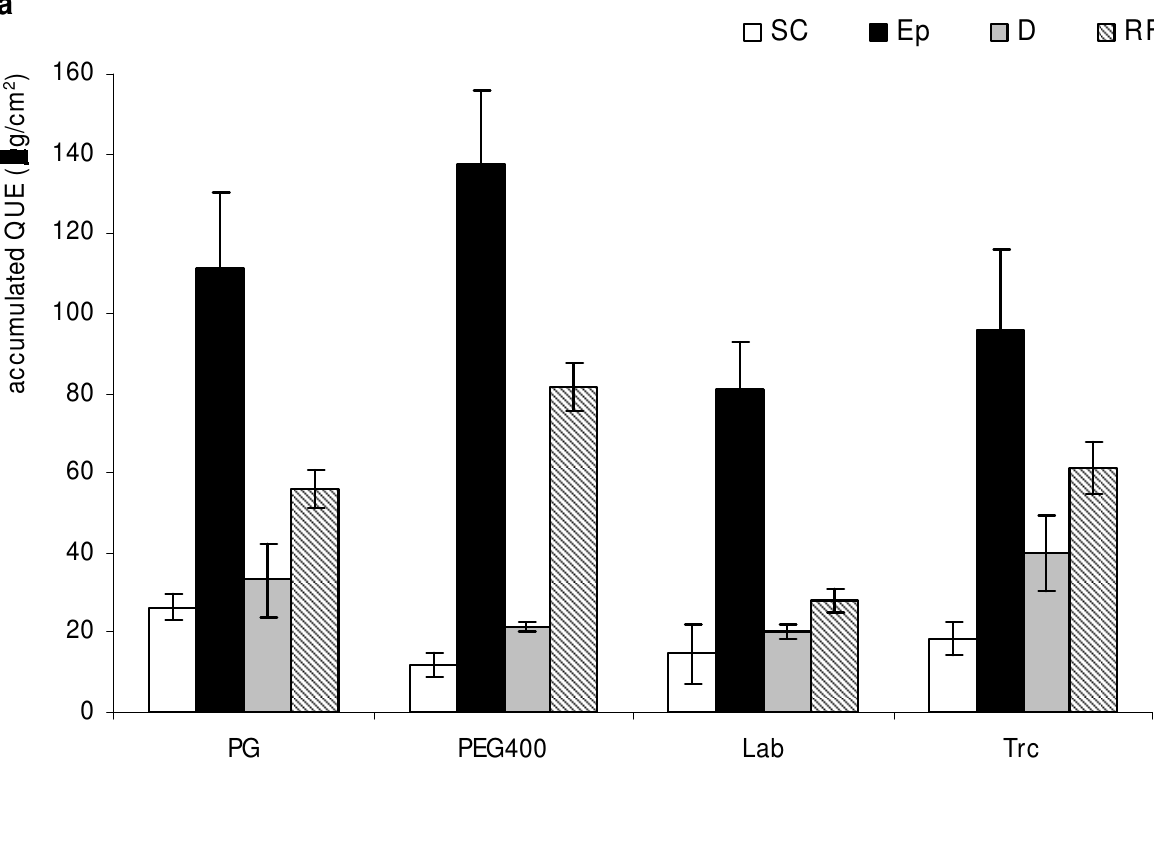
Figure 4. Determination of QUE deposition into pig skin layers (SC, stratum corneum; Ep, epidermis; D, dermis and RF, receptor fluid) after 8-h non-occlusive treatment: (a) QUE loaded in PEVs, (b) coarse dispersions of P50, PE and non-incorporated QUE. Each value is the mean ± S.D. of six experimental